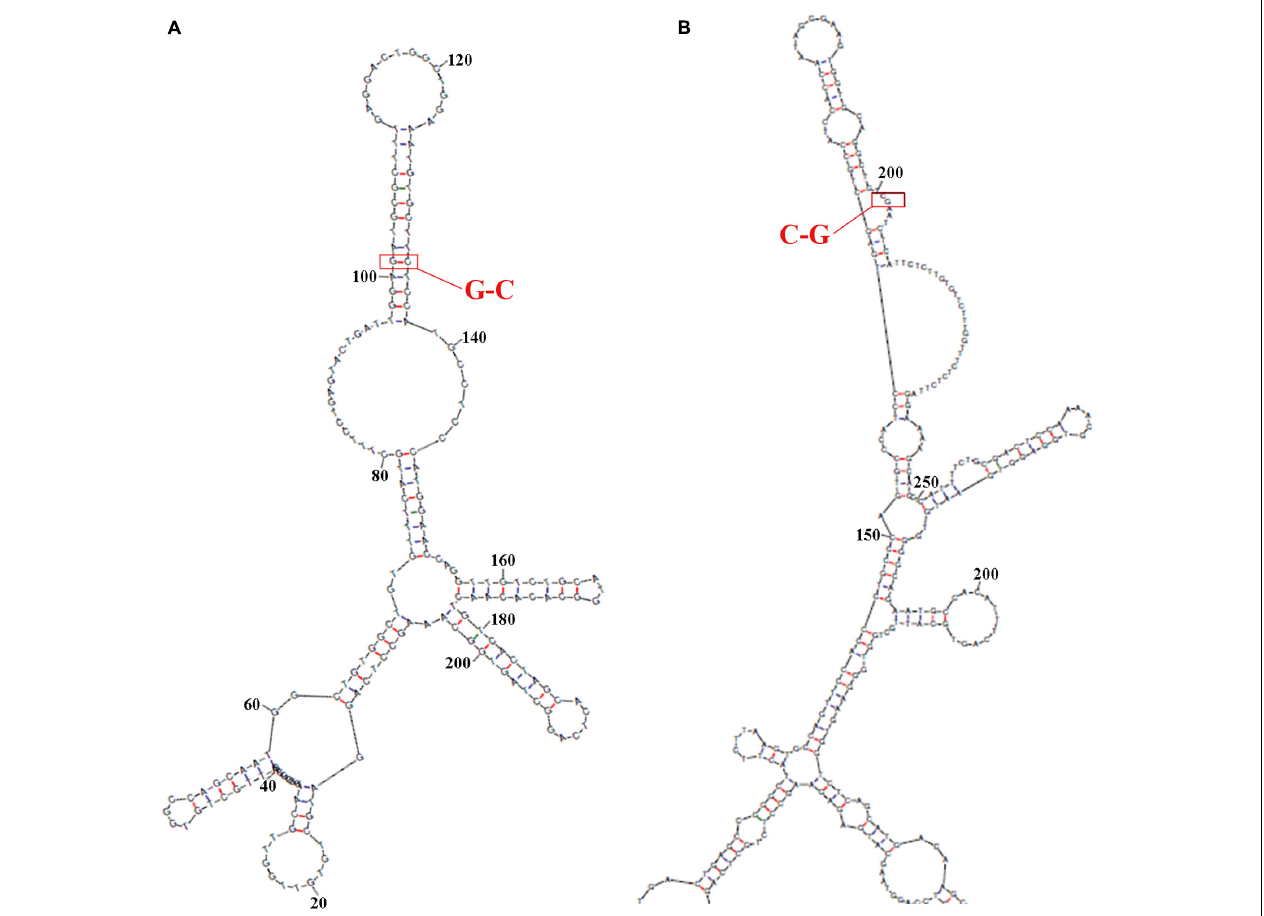
FIGURE 6 | Predicted secondary structures of DAB1 rs17115303 and PTPRT rs6030462. The secondary structure of the sequence from 100 bp upstream to 100 bp downstream of DAB1 rs17115303 and PTPRT rs6030462 mutation positions were analyzed using Mfold software. (A,B) Secondary structure prediction for the introns of DAB1 rs17115303 (A) and PTPRT rs6030462 (B) . The binding regions formed a hairpin structure. By overlaying observed SNPs (red triangles) and predicted binding sites (red lines) onto the secondary structure of DAB1 rs17115303 and PTPRT rs6030462, it was determined that the hairpin structure may be required for protein binding. The SNPs of both genes were located in the cap region and were predicted to destabilize the hairpin, thereby affecting splicing. SNPs, single-nucleotide